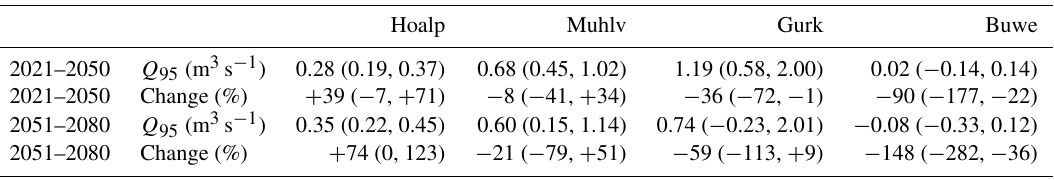
Table 2. Trend extrapolations of average Q 95 low flows (m 3 s − 1 ) for the periods 2021–2050 and 2051–2080 based on observed trends. Changes (%) refer to the Q 95 in the future period relative to the average Q 95 in the reference period (1976–2008). Values in parentheses indicate 95% confidence intervals.